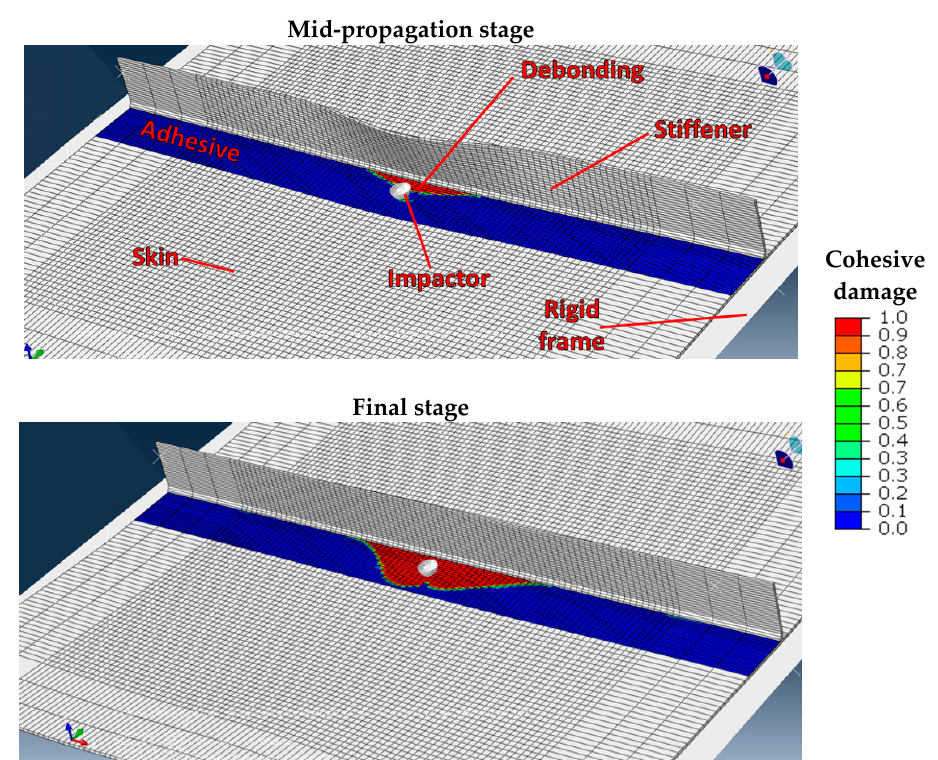
Figure 20. Damage of skin-stiffener bonding for a numerical simulation of impact at 30 J: debonding from the stiffener’s angle to the centre of its flange. The stiffener flange has been visually removed to appreciate the damage of cohesive elements located below.